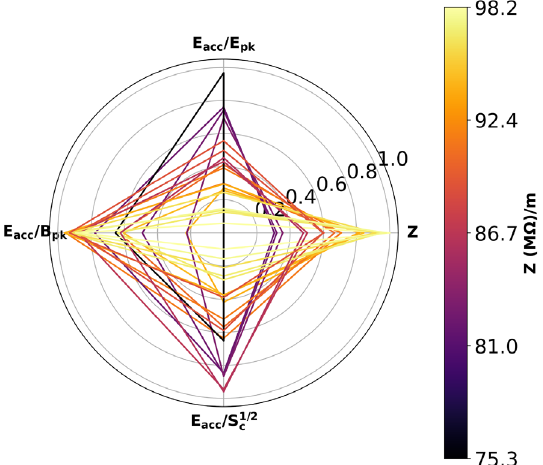
FIG. 19. Refined PCP for C-band SW single cell, showing four objectives with 30 clustered solutions.